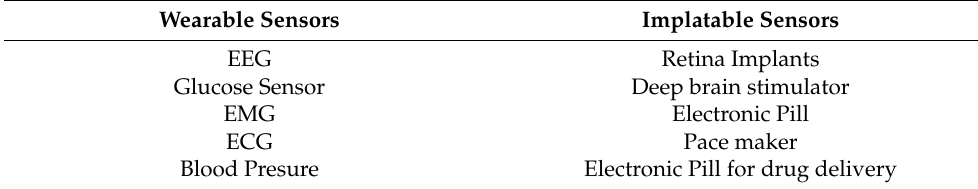
Table 3. Sensor in